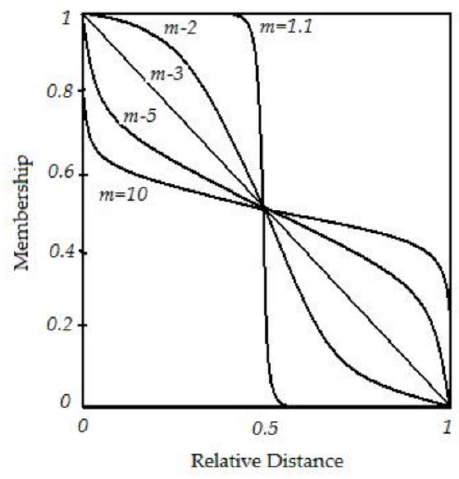
Figure 1. Membership of an element to a cluster for different values of m.